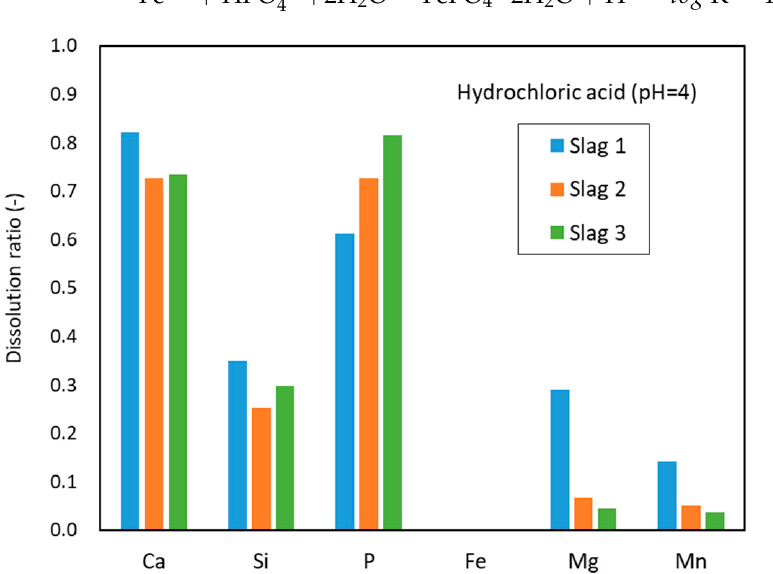
Figure 3. Dissolution ratio of each element from dephosphorization slag in hydrochloric acid solution at pH 4.